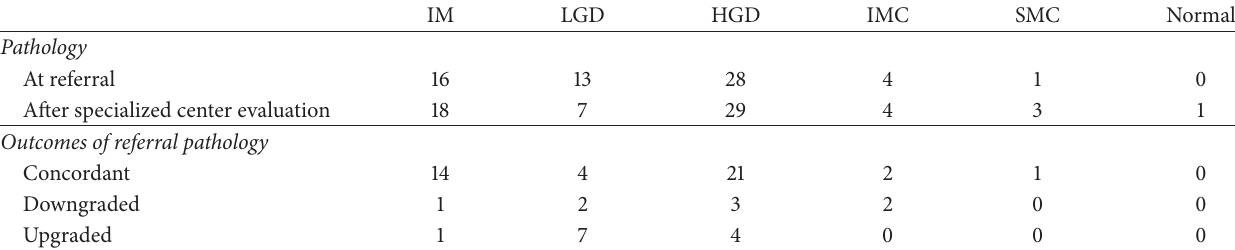
Table 3: Comparison of most advanced pathology at referral and after specialized center